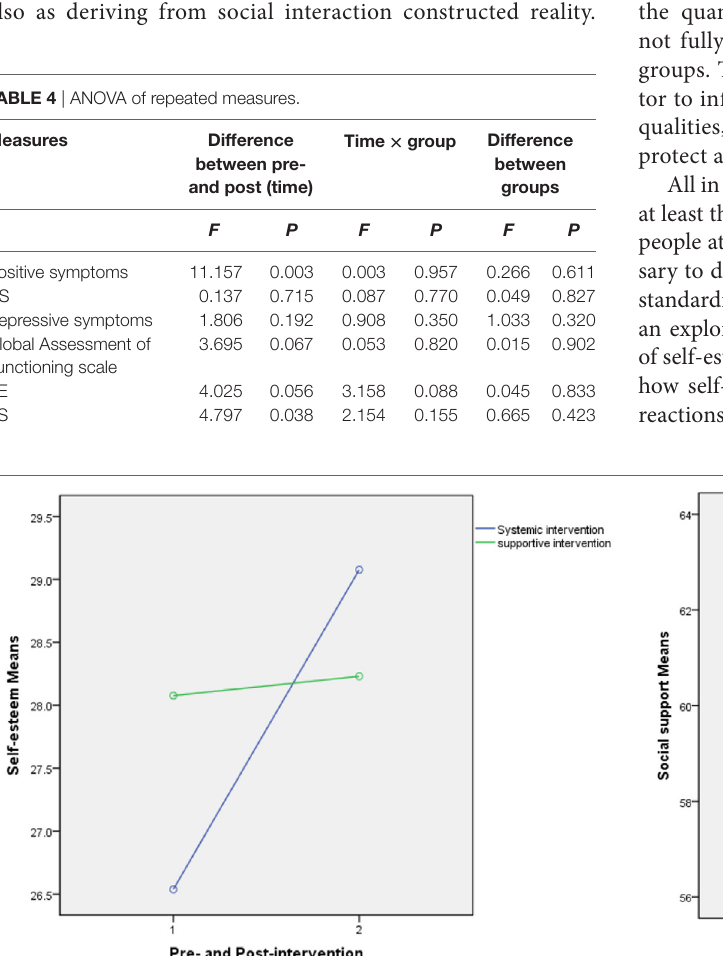
FigUre 2 | Improvements in level of self-esteem and social